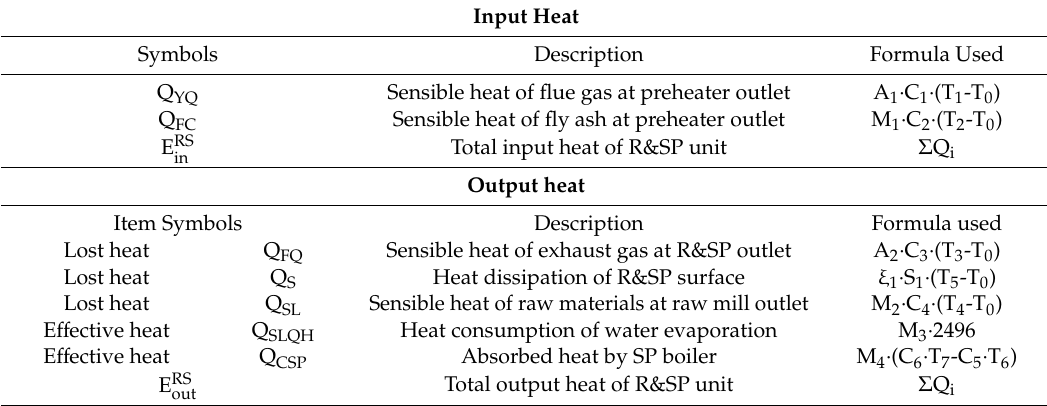
Table 1. Heat balance of the Raw Material Grinding and SP (R&SP)